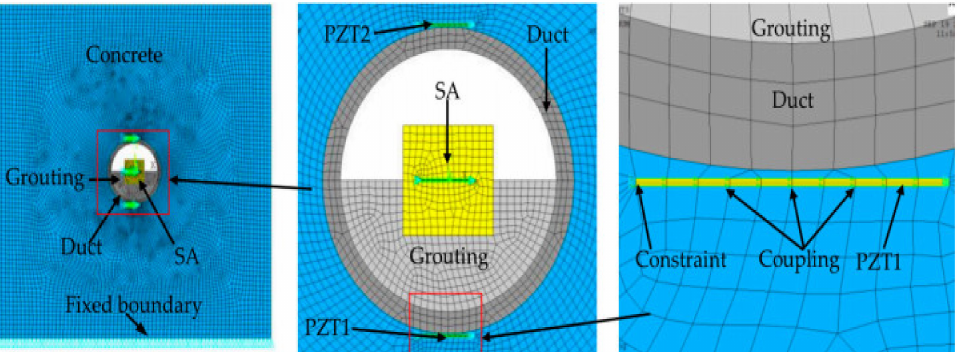
Figure 18. The mesh details of the finite element model. The blue is concrete, the light gray is grouting, the gray is duct, the yellow is PZT and SA, the green is coupling, and the sky blue is constraint [160].